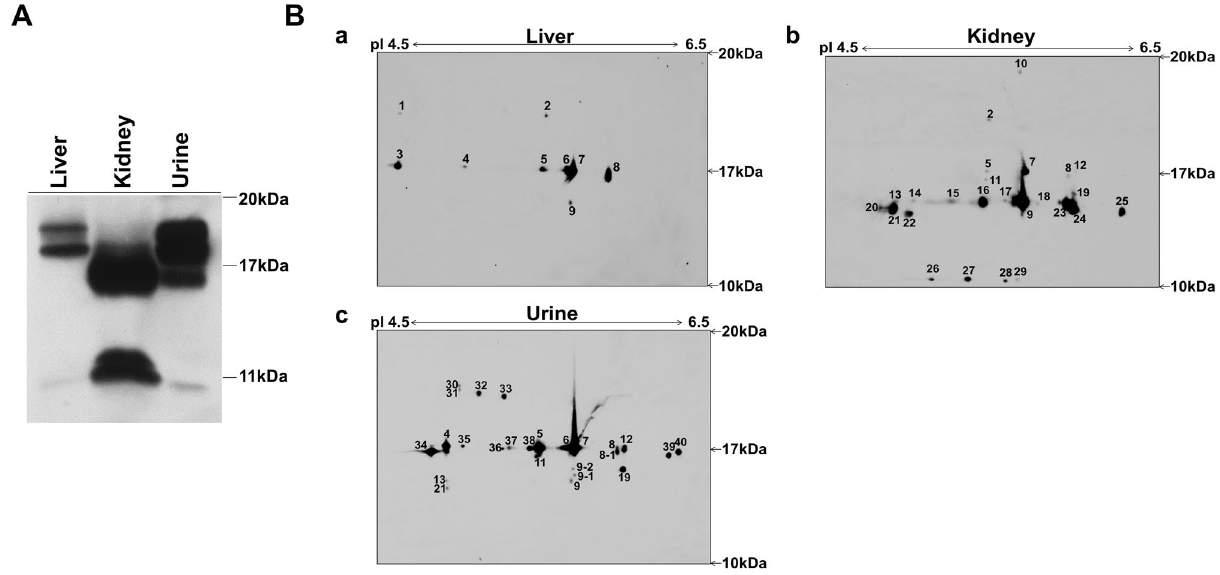
Figure 8. Identification of MUP isoforms in liver, kidneys, and urine in untreated rats by 1-DE Western blot and 2-DE immunoblot assays. ( A ) Comparison of MUP expression in the liver, kidneys, and urine by 1-DE Western blot analysis. Liver (10 μg), kidney (5 μg), and urine (0.0625 μg) proteins obtained from untreated rats were analyzed by 11.5% SDS-PAGE. ( B ) MUP isoforms in the liver, kidneys, and urine by 2-DE immunoblot assay. Liver, kidney, and urine proteins (600 μg, 300 μg, and 3 μg, respectively) obtained from untreated male rats were separated by 2-DE using pH 4–7 NL (24 cm) strips and 11.5% SDS-PAGE. Proteins (pI range from 4.5 to 6.5 pI; MW range from 10 to 20 kDa) were electroblotted onto PVDF membranes (20 × 14 cm). A total of 43 isoforms were found in the liver ( a ), kidneys ( b ), and urine ( c two kidney injury biomarkers Kim-1 and NGAL showed that TAA caused injury to the kidney proximal and distal tubules. Therefore, the significant downregulation of Tmod1 showed that TAA may play a critical role in kidney function. NQO2 is a cytosolic enzyme. The initial Northern blot findings in human specimens indicated that the highest expression was in skeletal muscle followed by kidneys, liver, lungs, and heart 54,55 . In previous studies using an NQO2 knockdown cell line and NQO2 siRNA, the inhibition of NQO2 activity induced the upregulation of anti- oxidant enzymes, which resulted in increased cellular resistance to oxidants and protected cellular components from oxidation-related damage 56–58 . Furthermore, high concentrations of resveratrol, which is a natural antioxi- dant agent, induced the downregulation of NQO2 expression, which inhibited the angiotensin II-induced genera- tion of reactive species oxygens in rat vascular smooth muscle cells 57,58 . An immunohistochemical toxicity study showed that TAA significantly reduced the expression level of NQO1 in rat renal tissues 59 . In the present study, NQO2 was significantly downregulated in the kidneys of rats exposed to the high concentration of TAA. The downregulation of NQO2 by TAA exposure might protect renal cellular components against oxidative damage. MUPs are low-molecular-weight (approximately 19 kDa) members of the large lipocalin family 60–63 . They are synthesized in the liver as precursors and, after excision of the signal peptide and formation of disulfide bonds, the small proteins are secreted into the bloodstream to be finally excreted into the urine 60–63 . MUPs are also expressed in other tissues, including the salivary, lachrymal, meibomian, mammary preputial, and perianal glands, nasal tissue, and respiratory epithelia 60–63 .